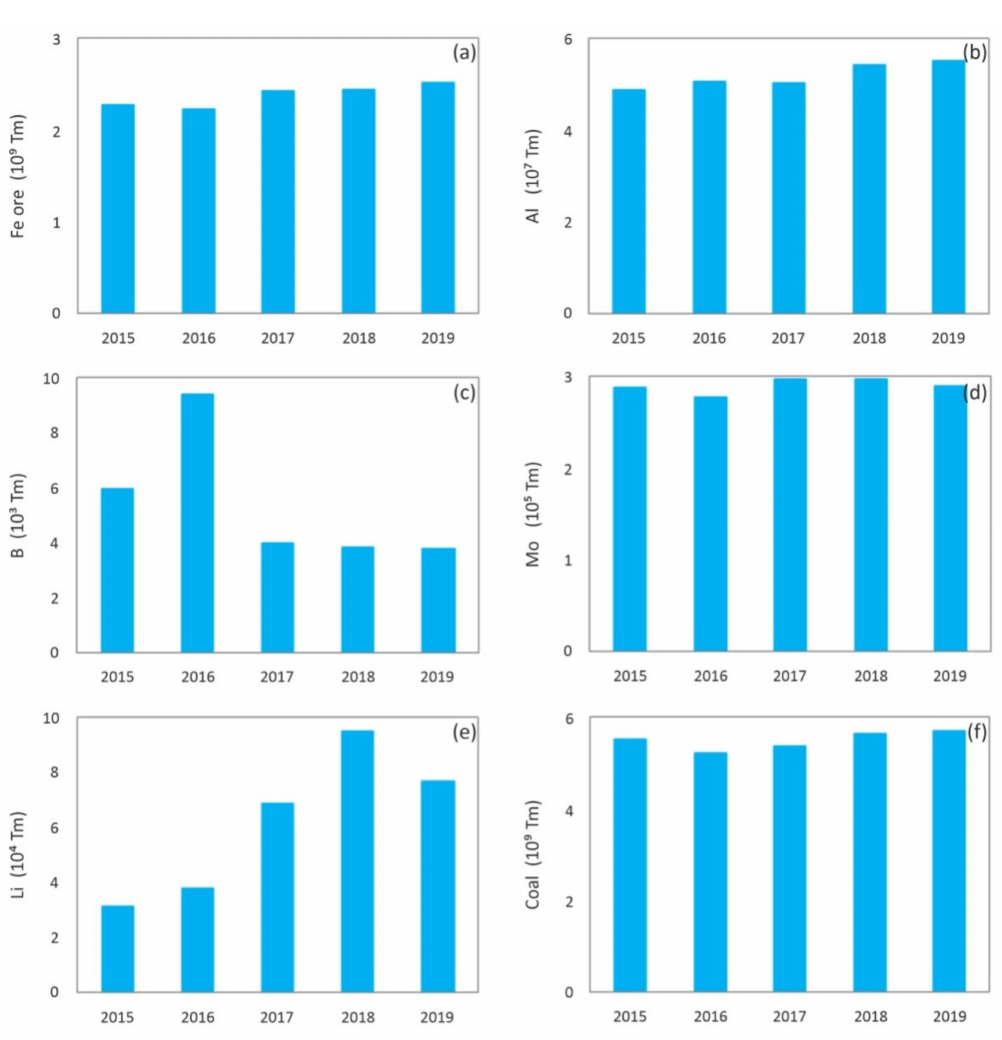
Figure 1. Evolution of world mineral production [2].